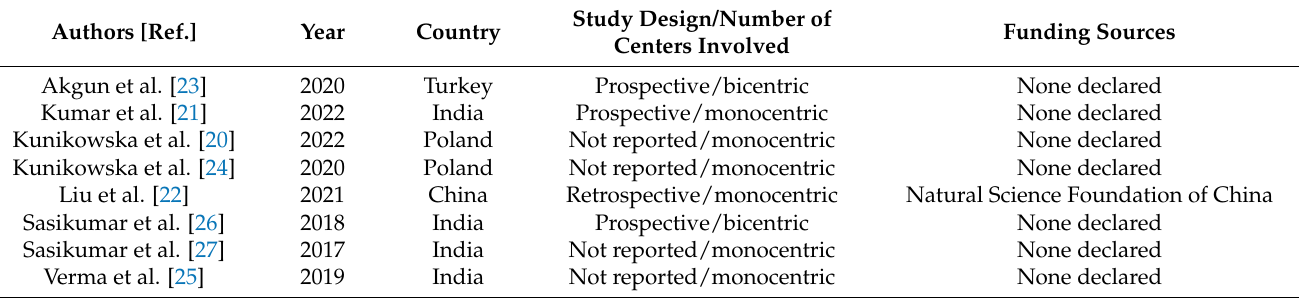
Table 1. General study information.